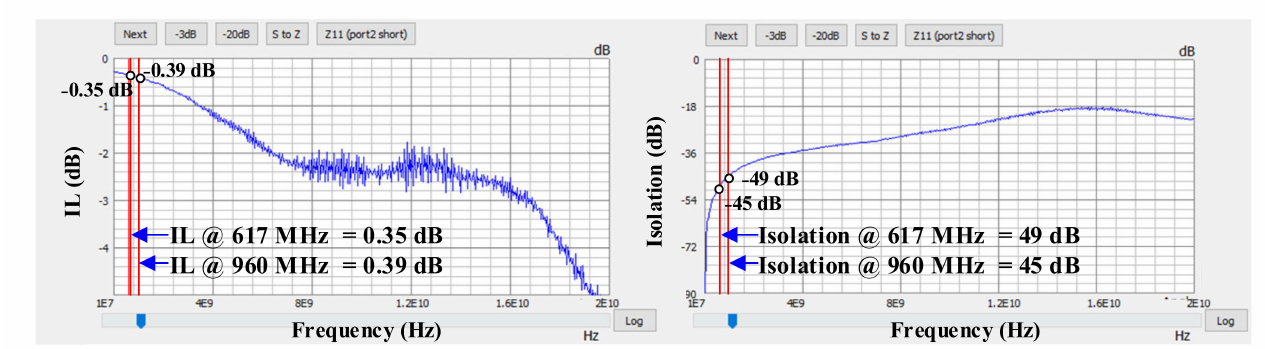
Figure 9. Measurement results of the S-Parameters for the low bands from 617 MHz to 960